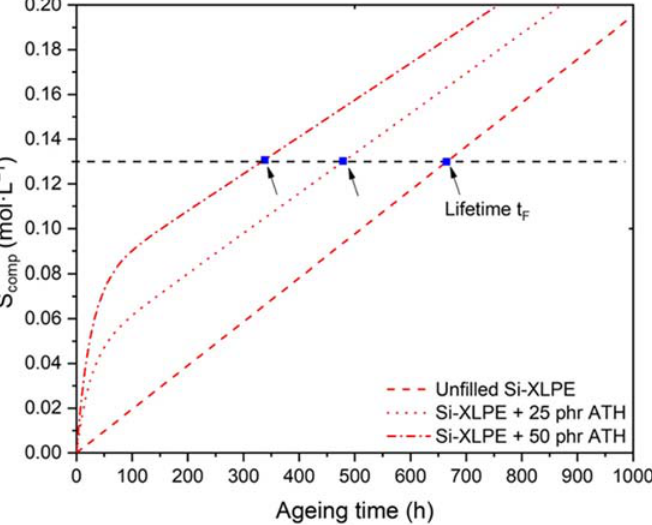
Figure 20. Prediction of the lifetime for the unfilled Si ‐ XLPE matrix and the composite materials with 25 phr and 50 phr of ATH, from the changes in their concentration of chain scissions during radio ‐ thermal exposure in air under 400 Gy ∙ h − 1 at 21 °C. The horizontal dotted line corresponds to the end ‐ of ‐ life criterion.